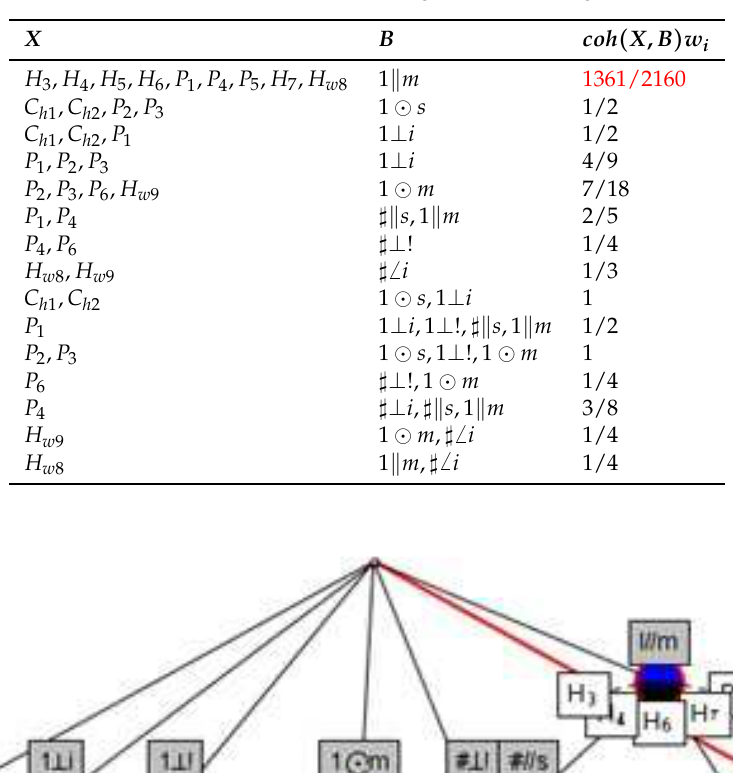
Table 12. The Coh value of a gear unit housing.